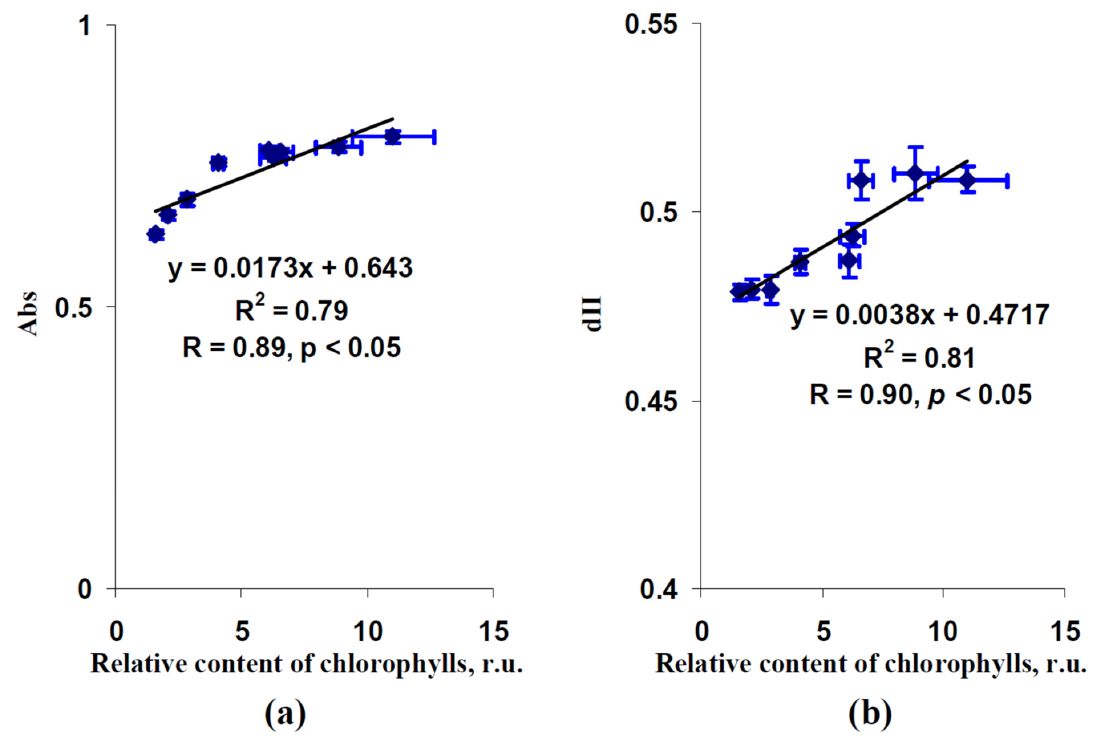
Figure 6. Dependences of the fraction of the actinic light absorbed by the leaves (Abs) ( a ) and fraction of the absorbed light distributed to photosystem II (dII) ( b ) on the relative content of chlorophylls in lettuce leaves. Average values from Figures 4 and 5 were used. R 2 and R are the determination and correlation coefficients.